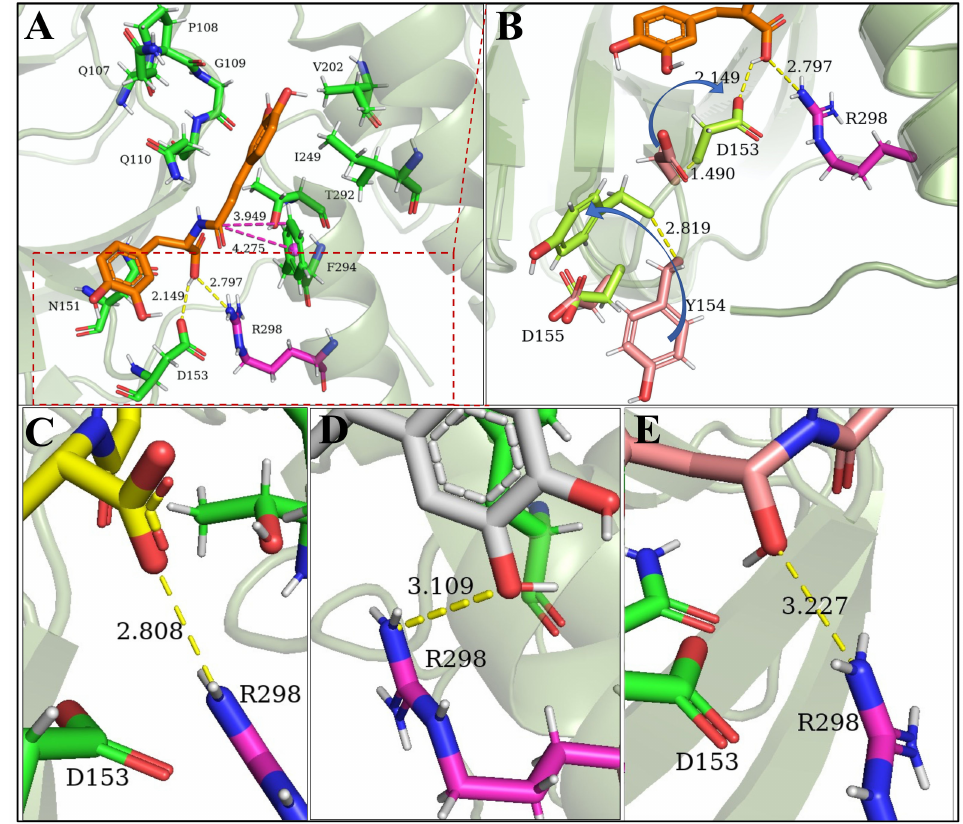
Figure 12. Allosteric site 2 locates in between domain II and III and contains a critical residue R298 responsible for protease dimerization, to which clovamide binds and interacts. ( A ): An overview of clovamide (orange) interacting with site 2 amino acid residues. The upper part is in the hy- drophobic pocket. Magenta lines indicate amide- π interactions. ( B ): Lower part of the molecule involves hydrogen bonds of the clovamide COOH to the D153 and R298 residues. This results in conformational changes of the 153–155 loop. Residues in wheat color indicates apo protein positions, while limon colors indicate their spatial positions after conformational change as a result of the ligand hydrogen bonds. The critical R298 residue is colored in pink. Blue arrows indicate the directions of conformational changes of the residues on the loop. Clovamide-R298 side chain interactions after replacement of the carboxylic acid group to carboxylate ( C ), hydrogen ( D ), and hydroxy group ( E ). Yellow dashed lines represent hydrogen